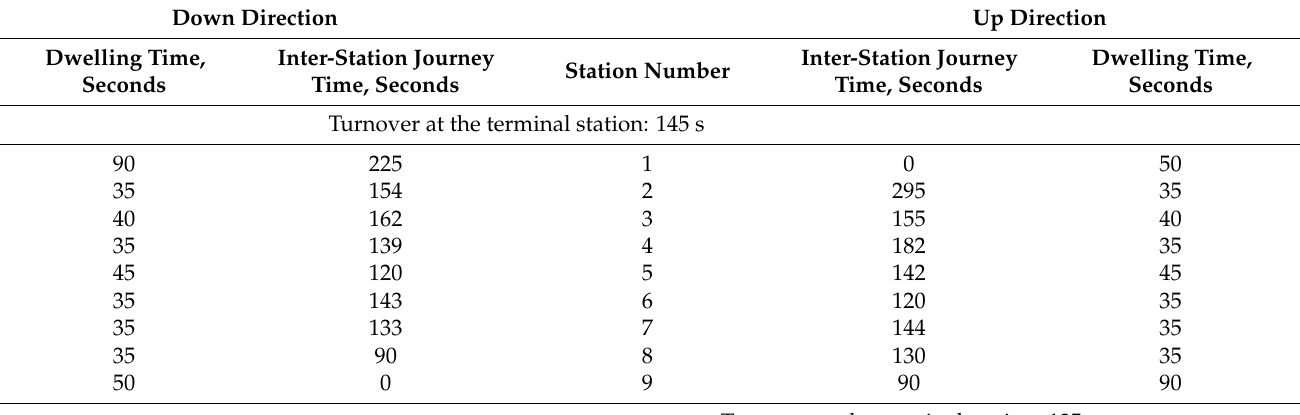
Table 2. The scheduled inter-station journey times.